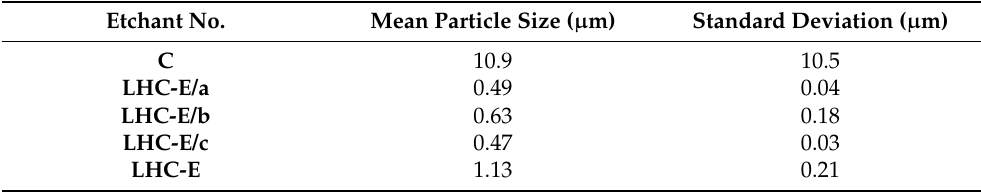
Table 3. The particle sizes of aromatic flocculent suspended in the lubricant after the heating test a.